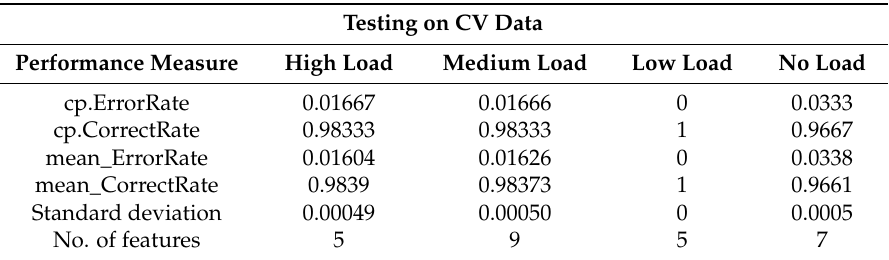
Table 7. Performance of multi-layer perceptron neural network (MLP-NN)-based classifier on cross-validation data.